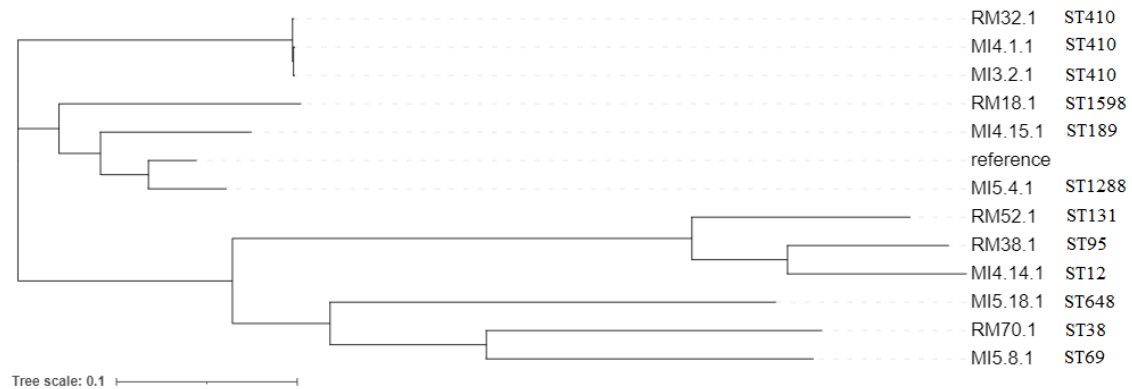
Figure 2. SNP-based phylogeny of CP- E. coli isolates from intestinal carriage in elderly patients. The maximum likelihood tree was rooted in a reference isolate E. coli strain K12 (accession no. NC_000913.2). Sequence type (ST) is shown for each isolate. Table 1. Molecular and resistome analysis of 12 CP- Escherichia coli isolates from carriage in elderly patients.